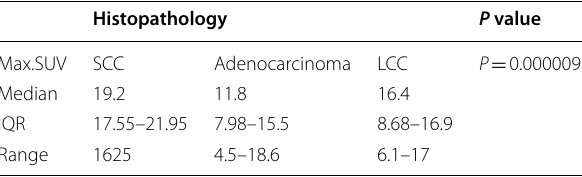
Table 2 Comparison of max.SUV in patient groups designated according to the histopathology of the primary lung tumor